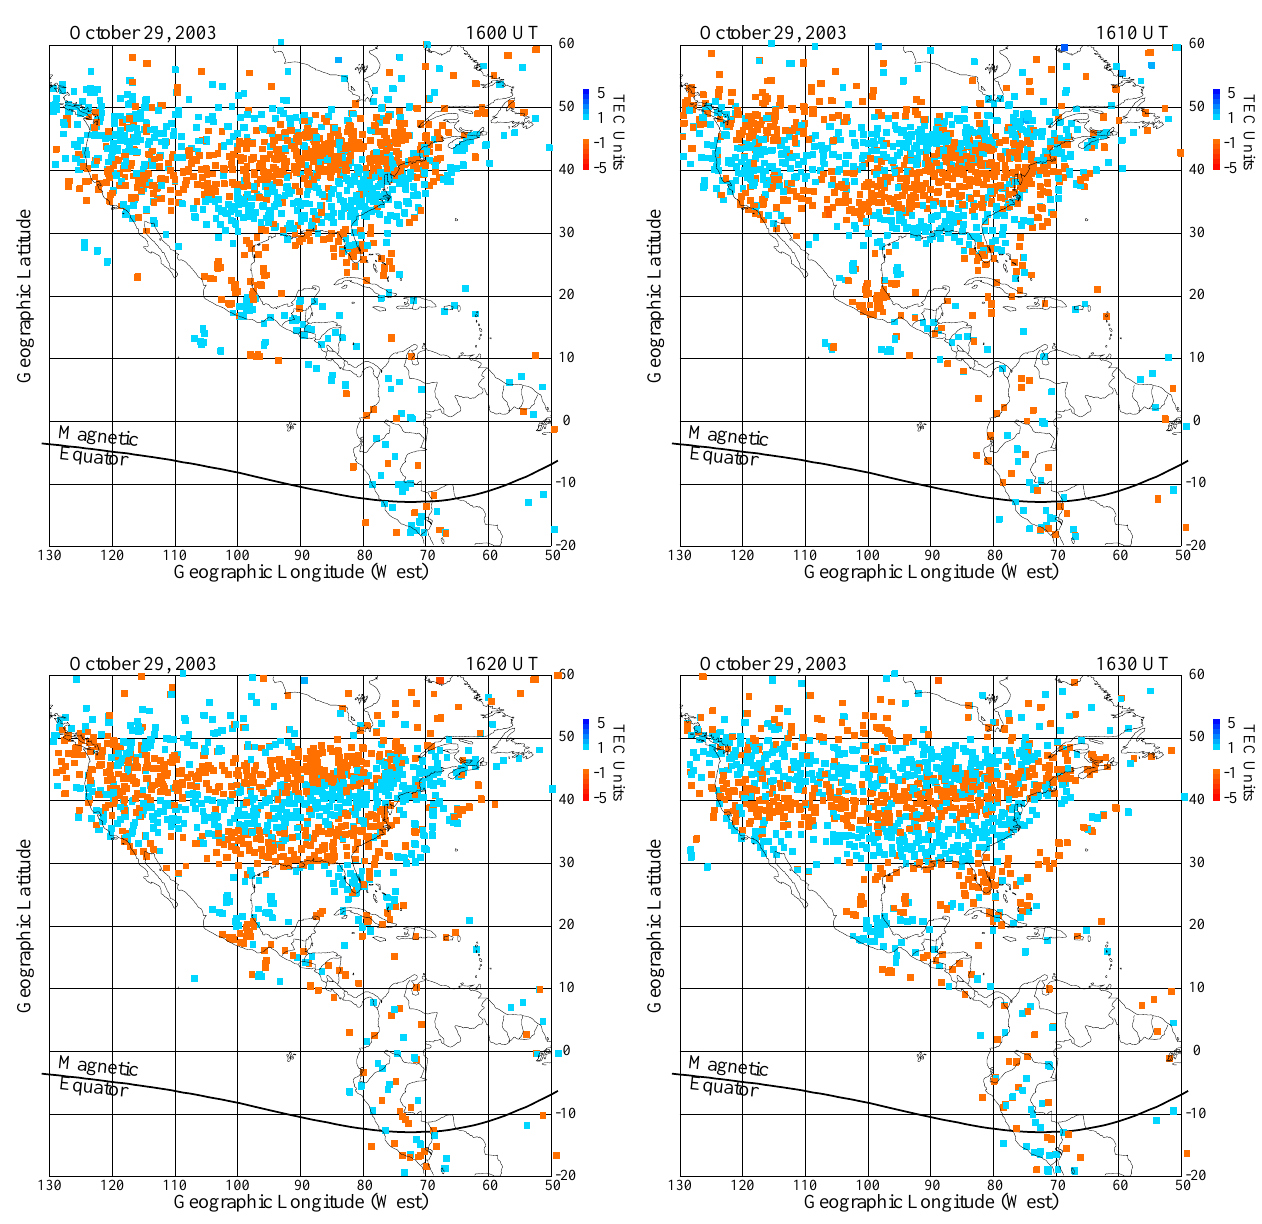
Fig. 2. Set of geographic displays of the distribution of TEC perturbations recorded in North America and the Caribbean region. Blue pixels indicate positive variations of the perturbations and red negative TECP values. Time interval between frames is 10min. See text for details.